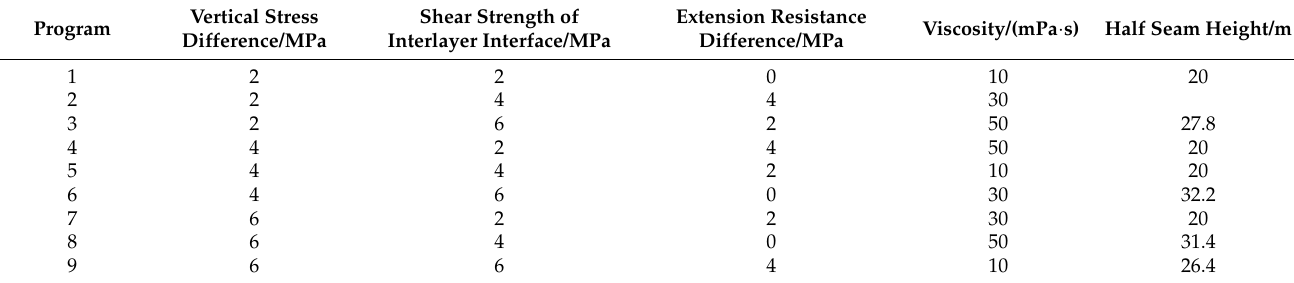
Table 4. Orthogonal test scheme